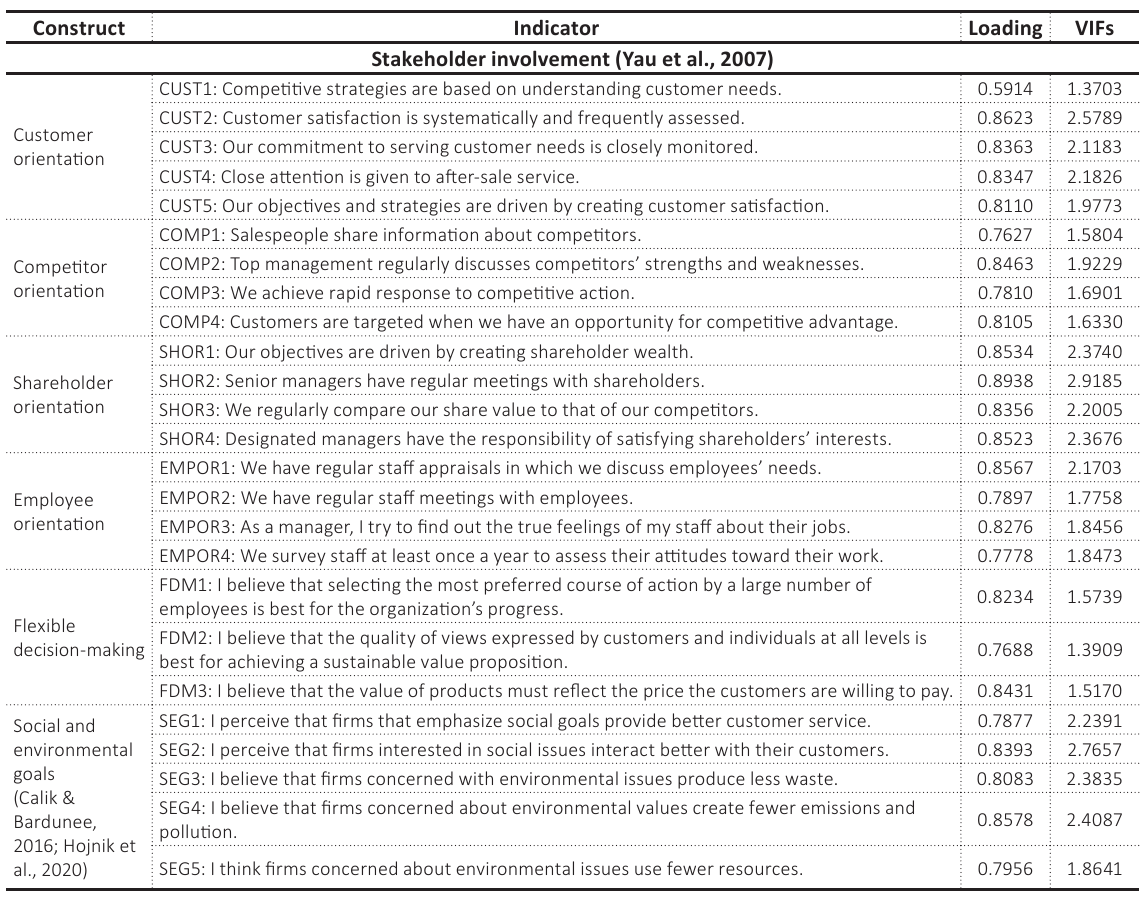
Table 3. Constructs, indicators, loadings, and variance inflation